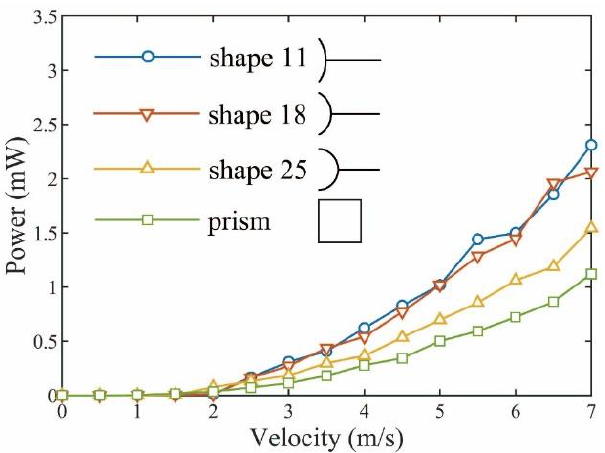
Figure 9. Variation of output power with wind velocity for WEHs with prism and arc-plate-shaped bluff bodies.